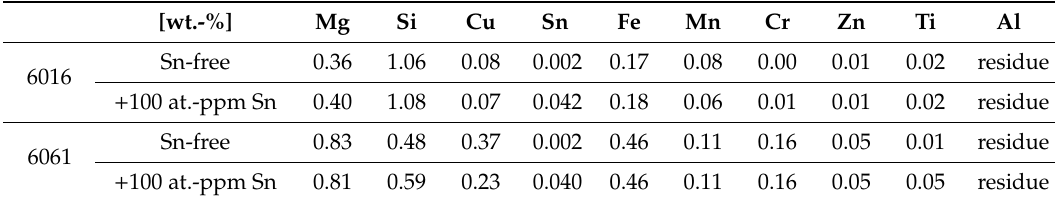
Table 1. Chemical composition of the EN-AW-6016 alloys used with and without 100 at.-ppm Sn and EN-AW-6061 with 100 at.-ppm